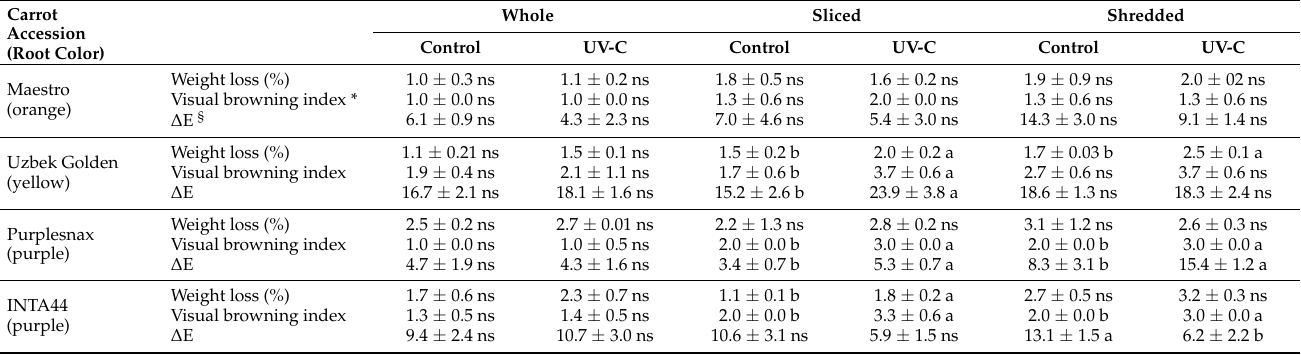
* Values for the visual browning index ranged from 1 (no browning) to 4 (severe browning). § Color change was estimated by the formula ∆ E = day 0 (prior to storage) and end of storage (indicated with the subindex 1 and 2, respectively) and L , a , and b , are CIELAB color space. Values are means ± standard deviation. Different letters in the same line indicate significant differences between control and UV-C treatments for a given sample type at p < 0.05, Fisher Test. ns. not